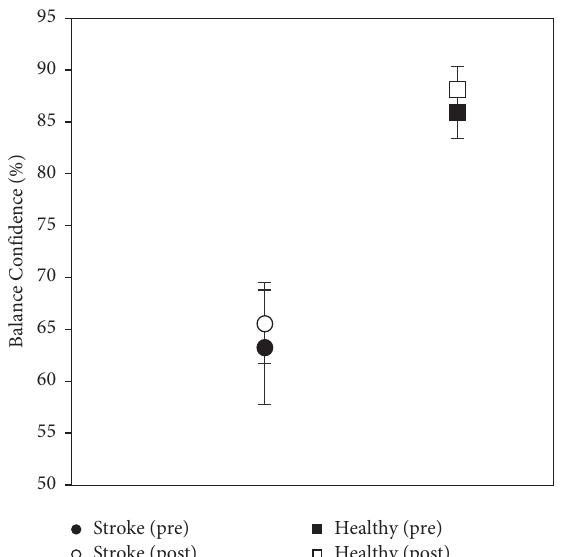
Figure 2: ABC Scale scores for 27 healthy (circle) and 7 chronic stroke (square) participants before (filled) versus after (open) training; means and standard errors are shown.